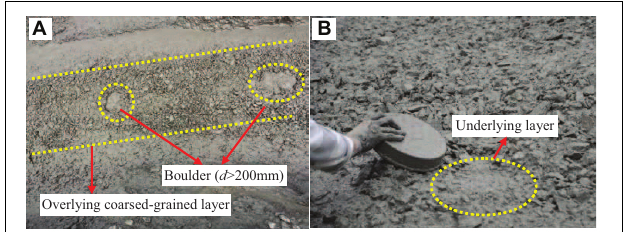
FIGURE 3 | Overlying coarse layer configuration.